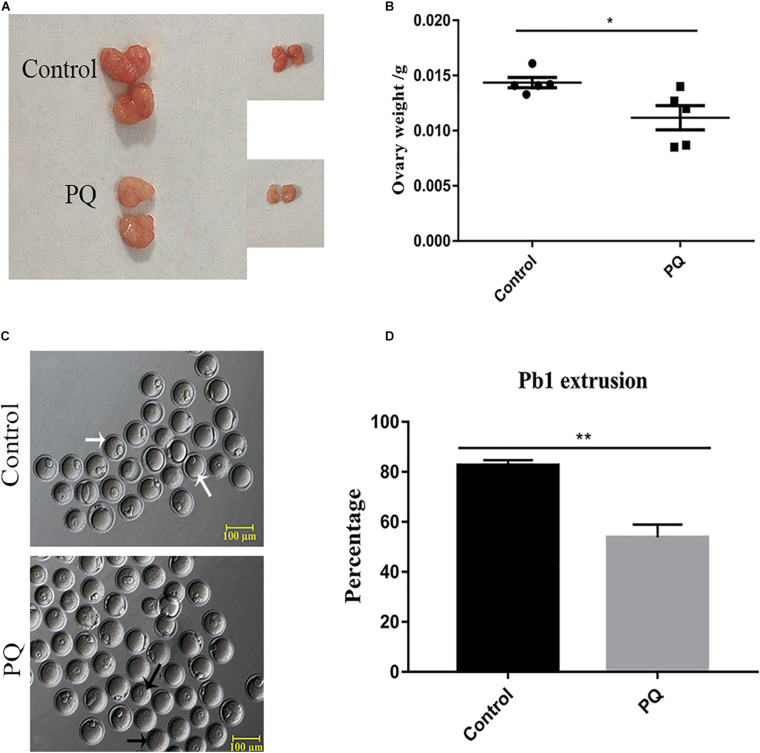
Paraquat (PQ) reduces the weight of ovary and disturbs first polar body (PB1) extrusion in mice. (A) Representative images of ovary from the control and PQ-treated groups. (B) The average weight of ovaries in the control and PQ-treated groups. (C) Representative images of PB1 extrusion from the control and PQ-treated groups. The white arrow indicates the oocyte with PB1 extrusion, and the black arrow indicates the oocyte without a PB1. Scale bar = 100 μm. (D) The percentage of PB1 extrusion in the control and PQ-treated groups. Data are presented as mean ± SEM from at least three independent experiments. ∗P < 0.05, ∗∗P < 0.01.